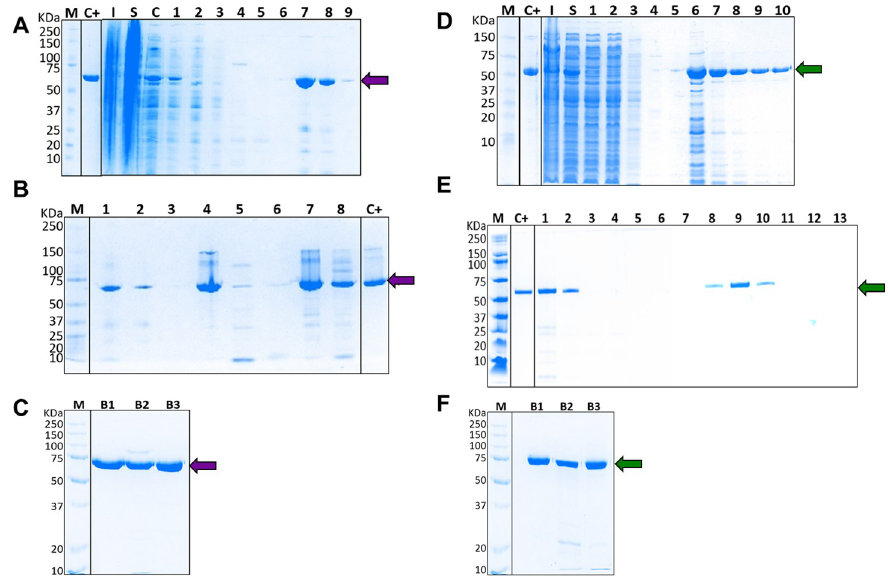
Fig 1. Expression and purification of recombinant Bacillus stearothermophilus DNA polymerase (Bst) and reverse transcriptase (RT) from Moloney Murine Leukemia Virus. Coomassie blue-stained 8% Tricine-SDS-PAGE electrophoresis gel analysis. (A) Expression of recombinant Bst enzyme and Ni 2+ -IMAC purification. Lane 1: clarified supernatant loaded; Lane 2: flow-through fraction; Lane 3–6: washing step fractions; Lane 7–9: eluted fractions containing Bst. (B) Heparin column purification of recombinant Bst. Lane 1: desalted sample loaded; Lane 2: flow- through fraction; Lane 3: washing step fraction; Lane 4–6: elution fractions; Lane 7–8: concentrated Bst-containing fractions. (C) Final Bst formulations from three different purification batches (B1, B2, B3). (D) Expression of recombinant RT enzyme and Ni 2+ -IMAC purification. Lane 1–3: flow-through fractions; Lane 4–5: washing step fractions; Lane 6–10: elution fractions containing RT. (E) Cation exchange column purification of recombinant RT. Lane 1: IMAC elution fraction; Lane 2: desalted sample loaded; Lane 3–5: flow-through fractions; Lane 6–7: washing step fractions; Lane 8–13: elution fractions. (F) Final RT formulations from three different purification batches (B1, B2, B3). M: molecular weight marker; C+: previously purified Bst or RT enzyme, employed as control positive; I: insoluble fraction; S: soluble fraction; C: clarified supernatant. Violet or green arrows indicate the expected size for Bst and RT enzymes, respectively.